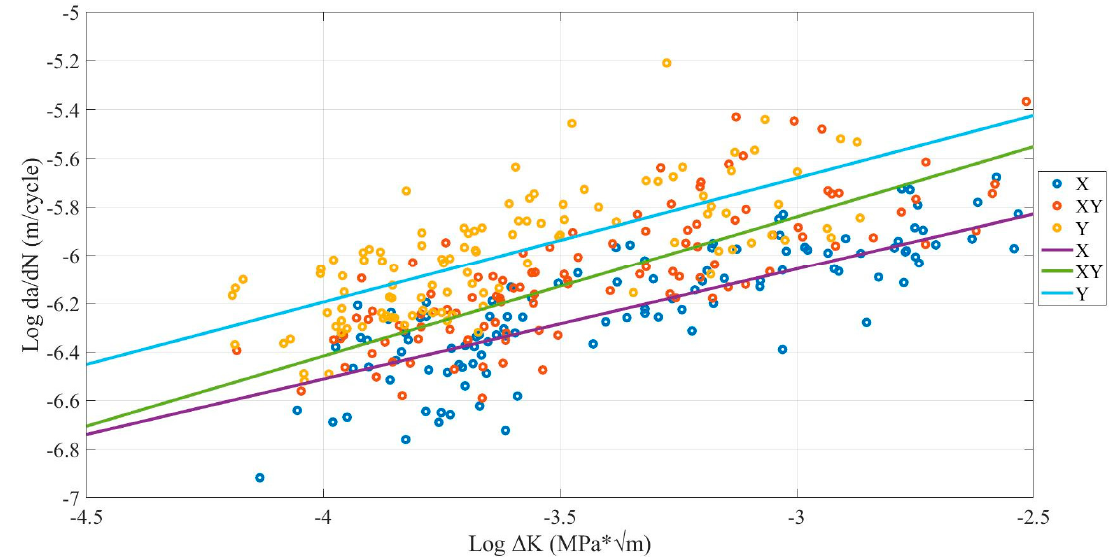
Figure 9. Comparison of building orientation influence on FCG rate for ABS samples with (0.4-, 0.6-, and 0.8-mm nozzle size and 0.05-, 0.10-, 0.15-mm layer thickness) under 50, 60, and 70 °C environmental temperatures. Table 5. The mean FCG rate and number of cycles of different orientations regardless of other print- ing parameters.